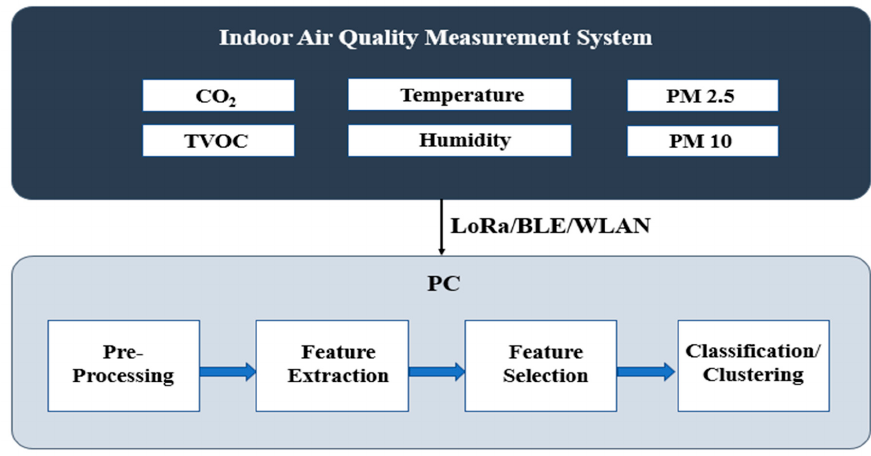
Figure 5. Block diagram of the measurement system and smoking detector.